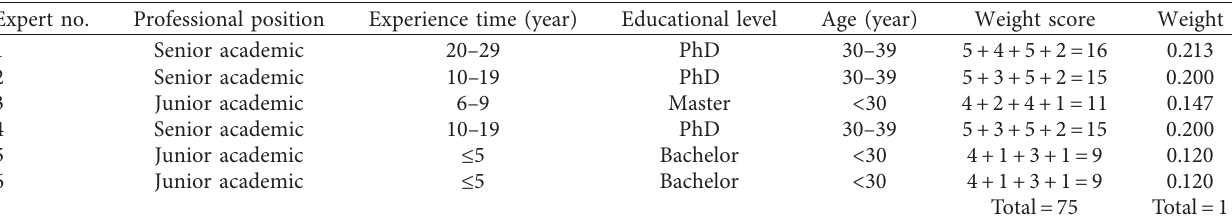
Table 5: Weight of different